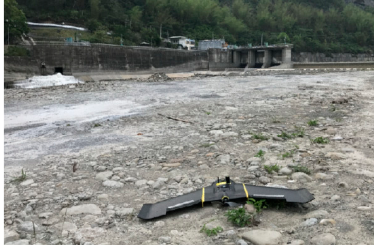
( c ) Figure 7. Three orthophotos of the study area taken on ( a ) 6 April 2016, ( b ) 10 April 2017, and ( c ) 22 May 2017. ( a ) ( d ) Figure 8. The picture of different bands taken by the Parrot Sequoia multispectral camera (2 May 2017) and mosaiced by pix4D software. ( a ) green band, ( b ) red band, ( c ) red edge band, and ( d ) NIR band.